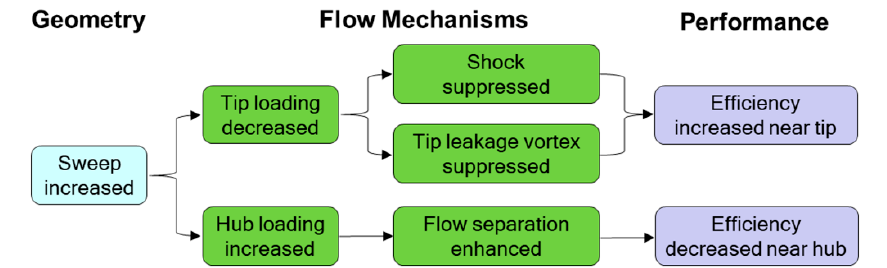
Figure 23. Illustration of sweep mechanism.